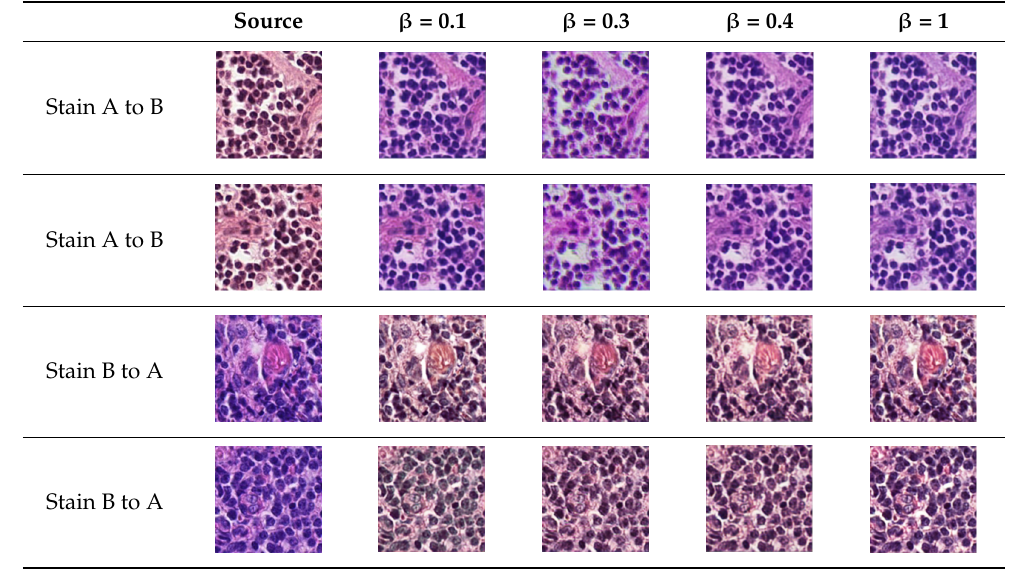
Figure 12. Seven randomly selected snapshots from network outcomes of seven independent runs, ( a ) without and ( b ) with the specialized color classifier using S3CGAN architecture.